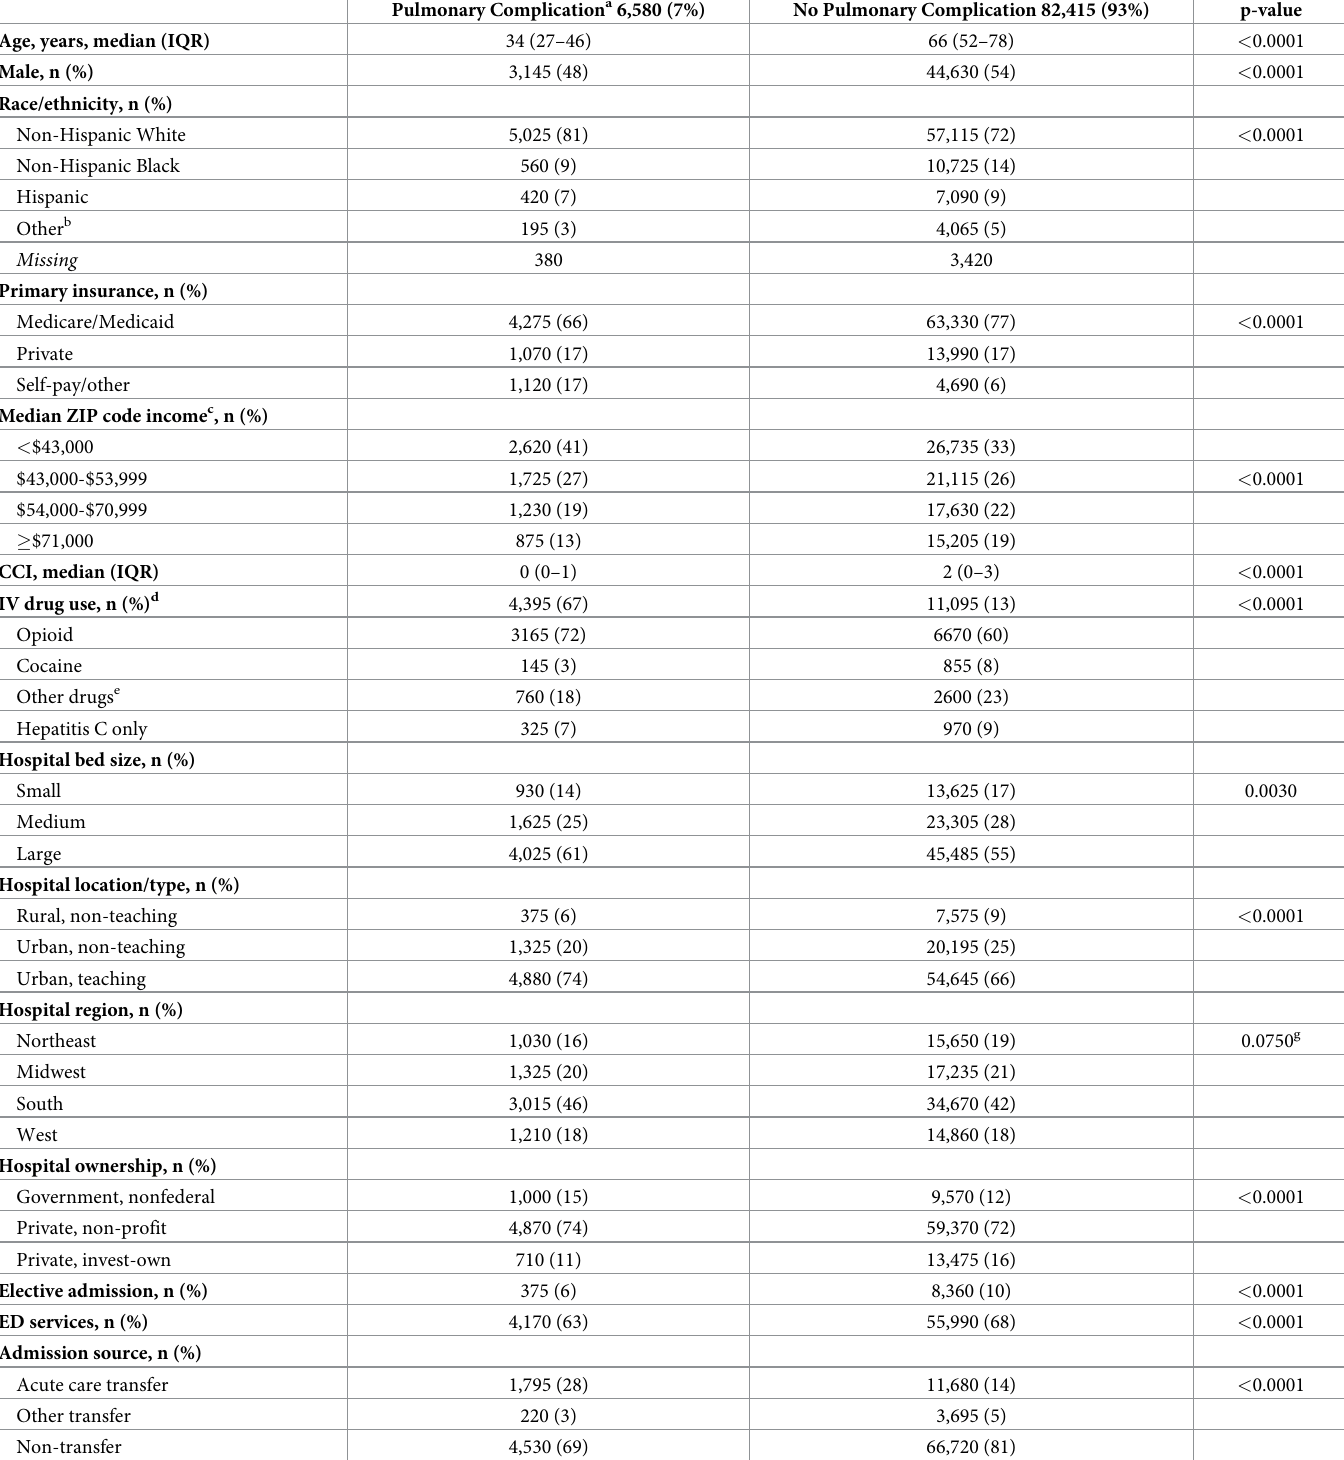
Table 1. Patient demographics and hospital characteristics, stratified by inpatient pulmonary